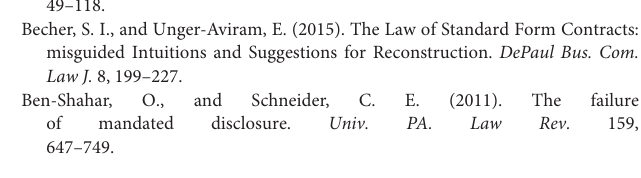
Supplementary Table 1 | Frequency statistics of decision